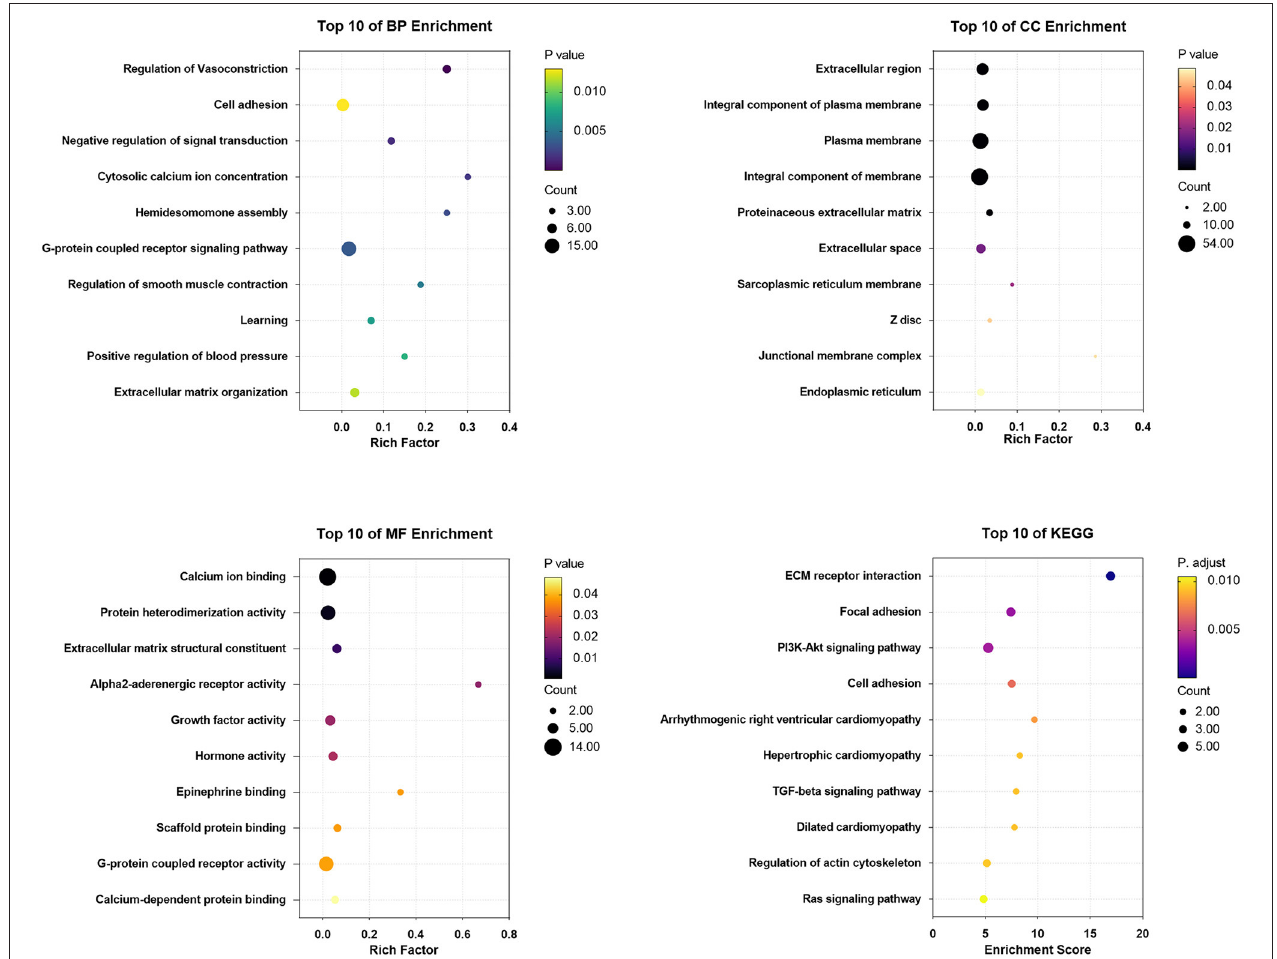
FIGURE 9 | The enrichment analysis of DEGs in CPI vs. CFs by DAVID and Metascape. Detailed information relating to changes in the CC, BP, MF, and KEGG analysis for hub genes is